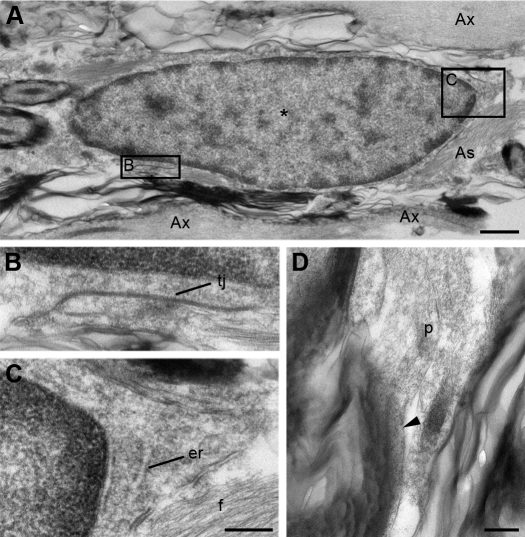
Ultrastructure of an Ependyma-Derived OligodendrocyteElectron micrograph of an ependyma-derived β-gal–expressing cell in the nuclear plane 10 mo after injury (nucleus labeled with asterisk in [A]). (A) The cell displays ultrastructural characteristics of a mature oligodendrocyte such as a denser cytoplasm with fewer intermediate filaments than that of a neighboring astrocyte (As), (B) tight junctions (tj) between the cell body, and an oligodendrocyte process of another cell and (C) granular endoplasmic reticulum (er) cycternae in the perikaryon. Ax, axon; f, filamentous matrix.(D) A process (p) of the cell adjacent to the myelin sheath on an axon.Scale bars indicate 1 μm in (A) and 250 nm in (C) and (D).